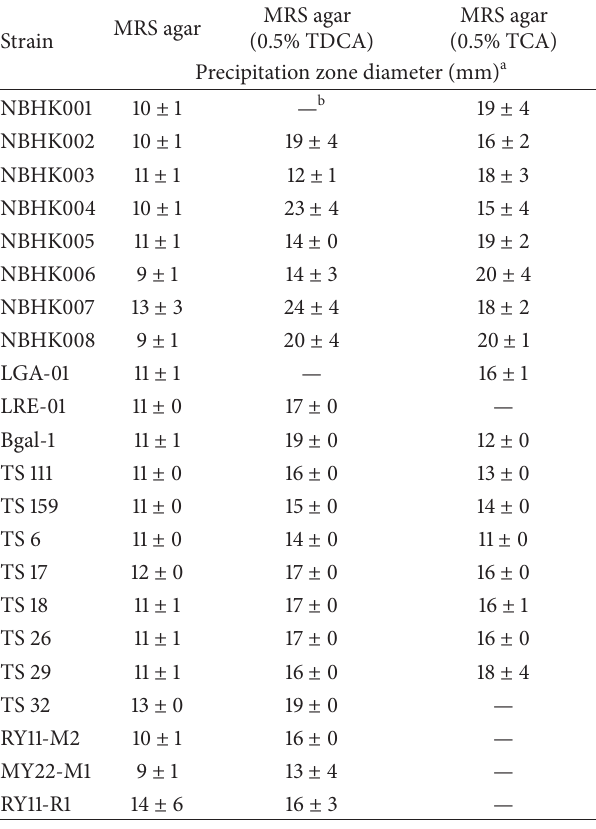
Figure 1: Deconjugation activity of the probiotics. a , b , c Means with different superscript letters within the same culture are significant differences ( 𝑃 < 0.05 ) by Duncan’s multiple range test.